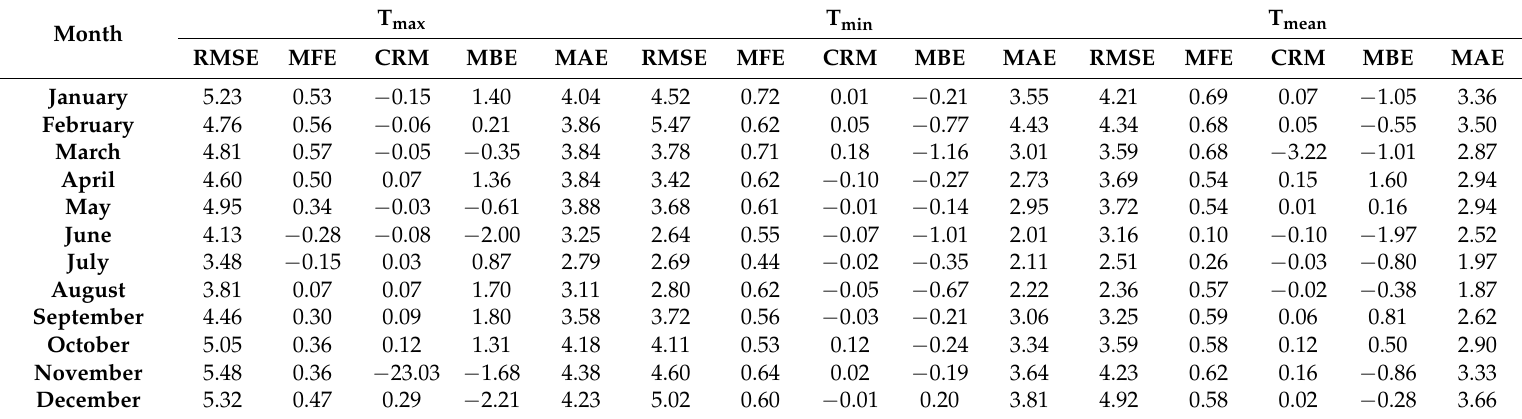
Table 5. The performance of optimal models for T max , T min , and T mean in different months. Model accuracy is given by RMSE, MEF, CRM, MAE, and